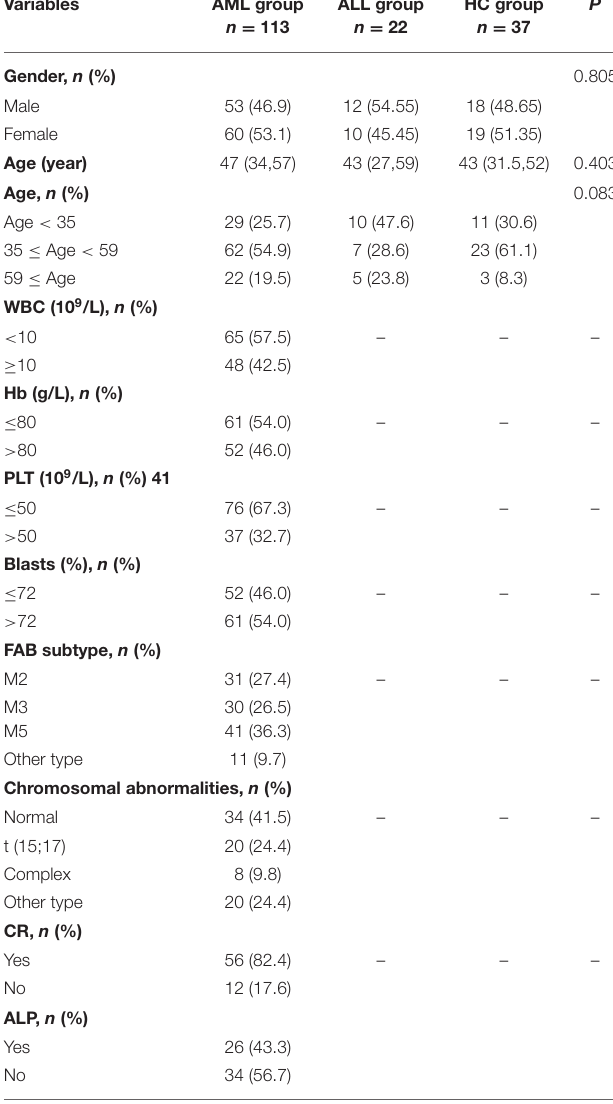
TABLE 1 | Characteristics of the subjects in this